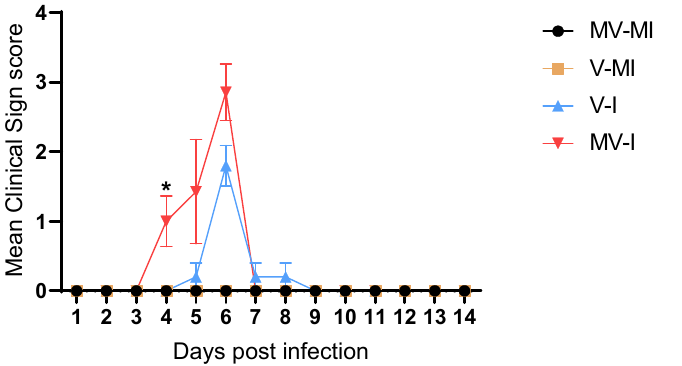
Figure 3. The observed mean clinical scores during experimental period. The mean clinical scores are given, and the error bars represent the standard error of means (SEM). Kruskal–Wallis test followed by Dunn’s multiple comparison test was performed to compare mean clinical scores of groups. * = p < 0.05.